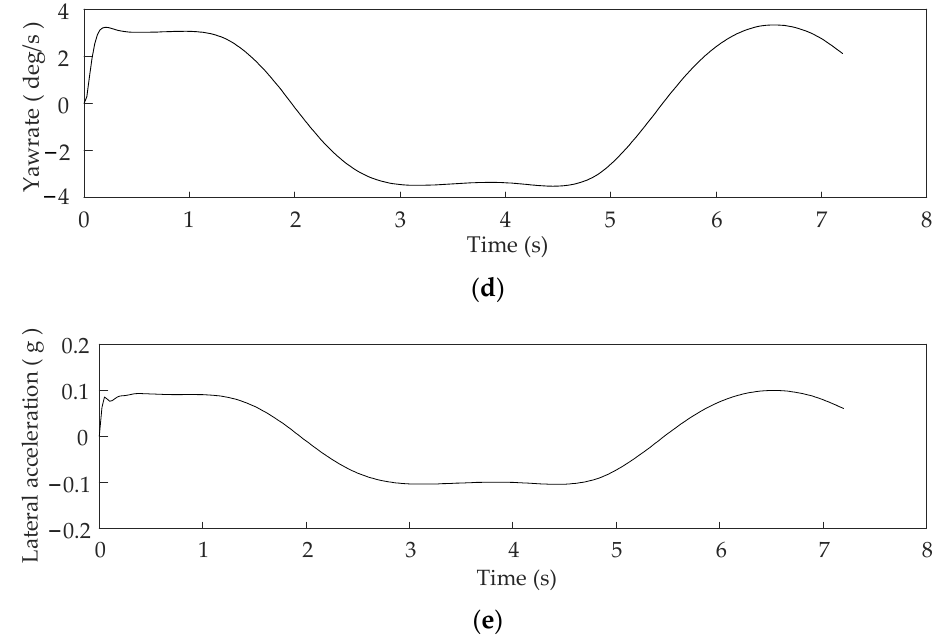
Figure 11. Path tracking results in the straight road environment. ( a ) Planned path on straight road. ( b ) Path following result on straight road. ( c ) Path following error on straight road. ( d ) Yaw velocity on straight road. ( e ) Lateral acceleration on straight road.